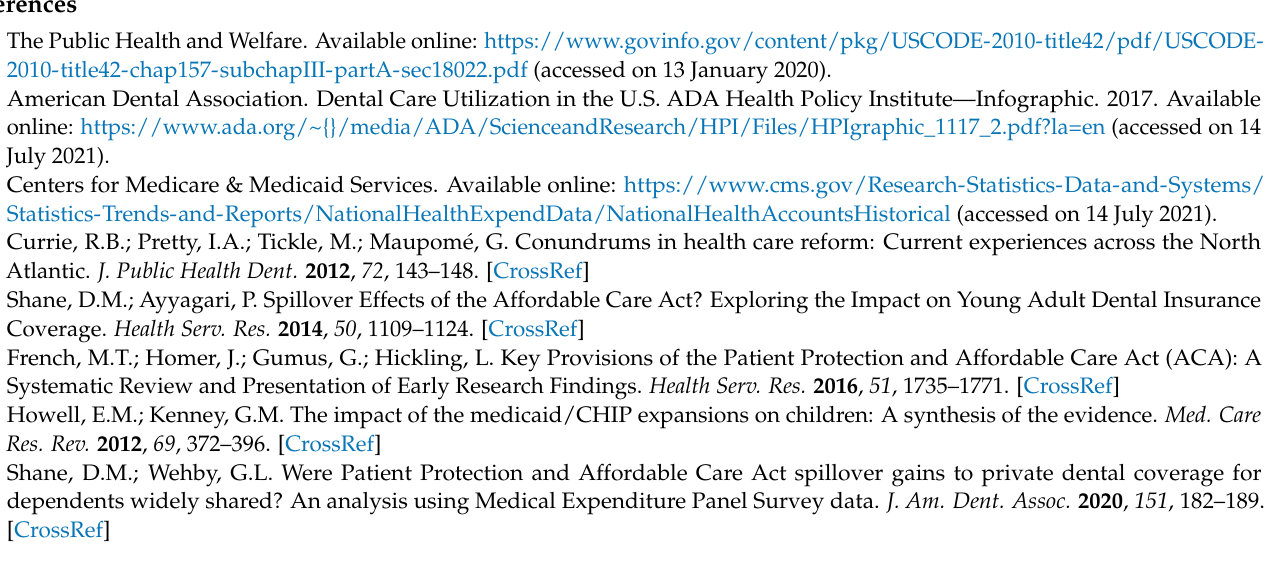
Figure S2: Funnel